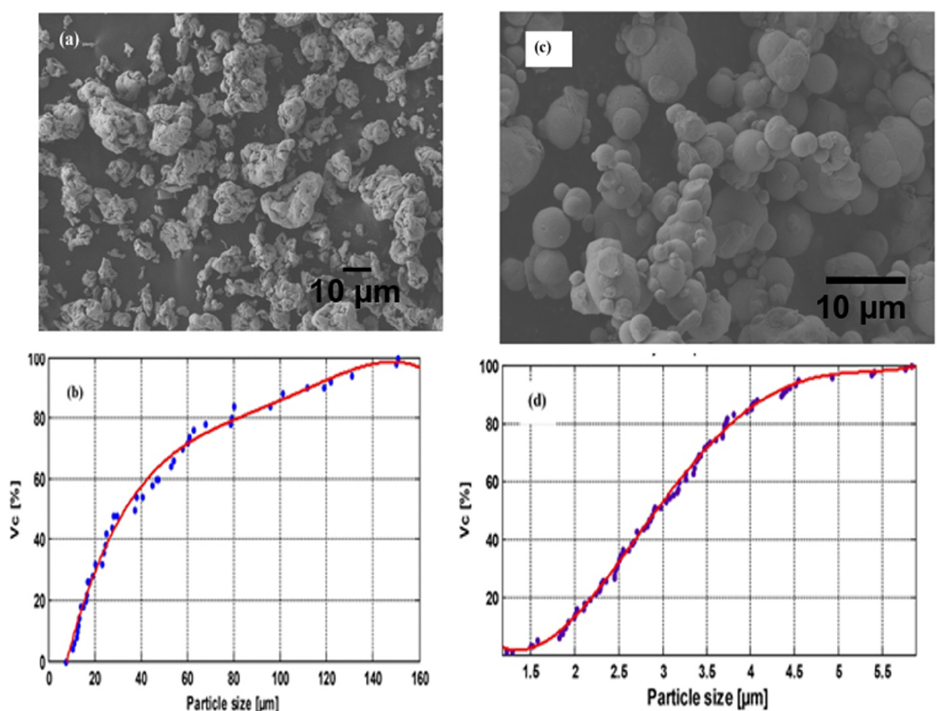
Figure 3. ( a , b ) SEM image of the graphite filler and its volume distribution of graphite particle size (20–150 µm) ( c , d ) SEM image of the carbonyl iron filler and its volume distribution of particle size (1–5 µm).